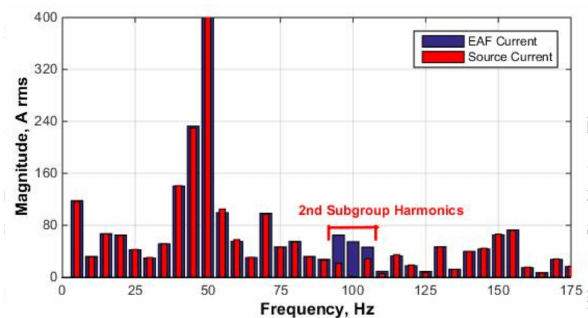
Figure 12. Harmonic spectrum of the load (field data) and source current in phase-A (simulation results), referring to the MV side.